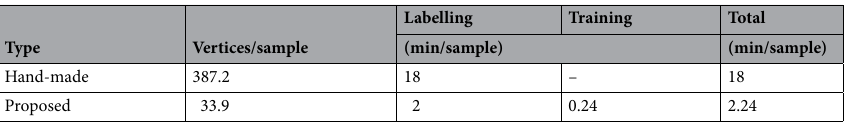
Table 5. Comparison of time required for labeling by manual means and the proposed method for a few samples.